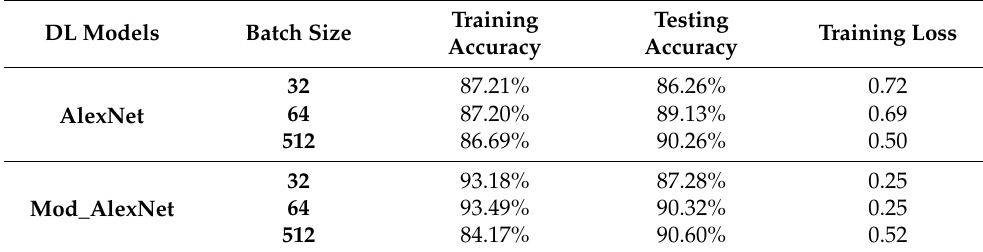
Table 7. RMSProp optimizer performance (3 epochs and batch sizes: 32, 64, and 512). DL